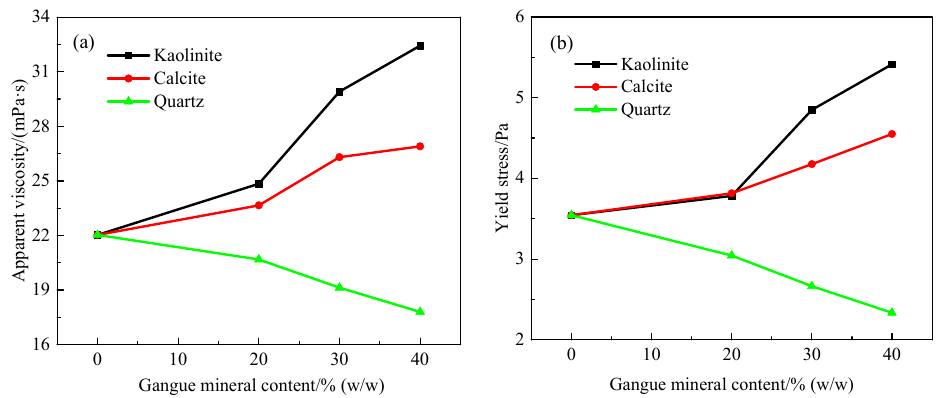
Figure 2. Effect of gangue mineral content on ( a ) apparent viscosity and ( b ) yield stress of smithsonite pulp using octadecylamine concentration: 150 mg/L at pH 9.5−10 and 28.57% solid concentration.